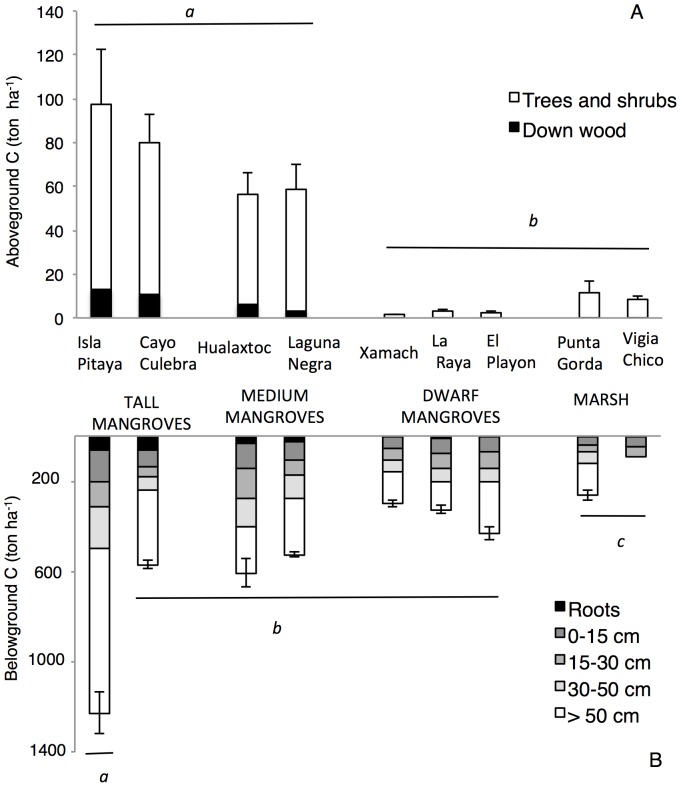
Ecosystem C stocks of coastal wetlands of Sian Ka'an Biosphere Reserve.The stocks are partitioned by A) aboveground (trees and down wood) and B) belowground (roots and soil) components. Lower case letters represent significant differences among sites and vegetation types (n = 6 per site, p≤0.0001). Note different scales between panel A and B.